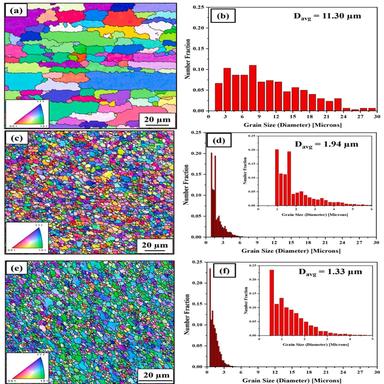
EBSD grain boundary maps and grain size distribution histograms of (a-b) Base, (c-d) WOR_3 and (e-f) WR_3 condition.